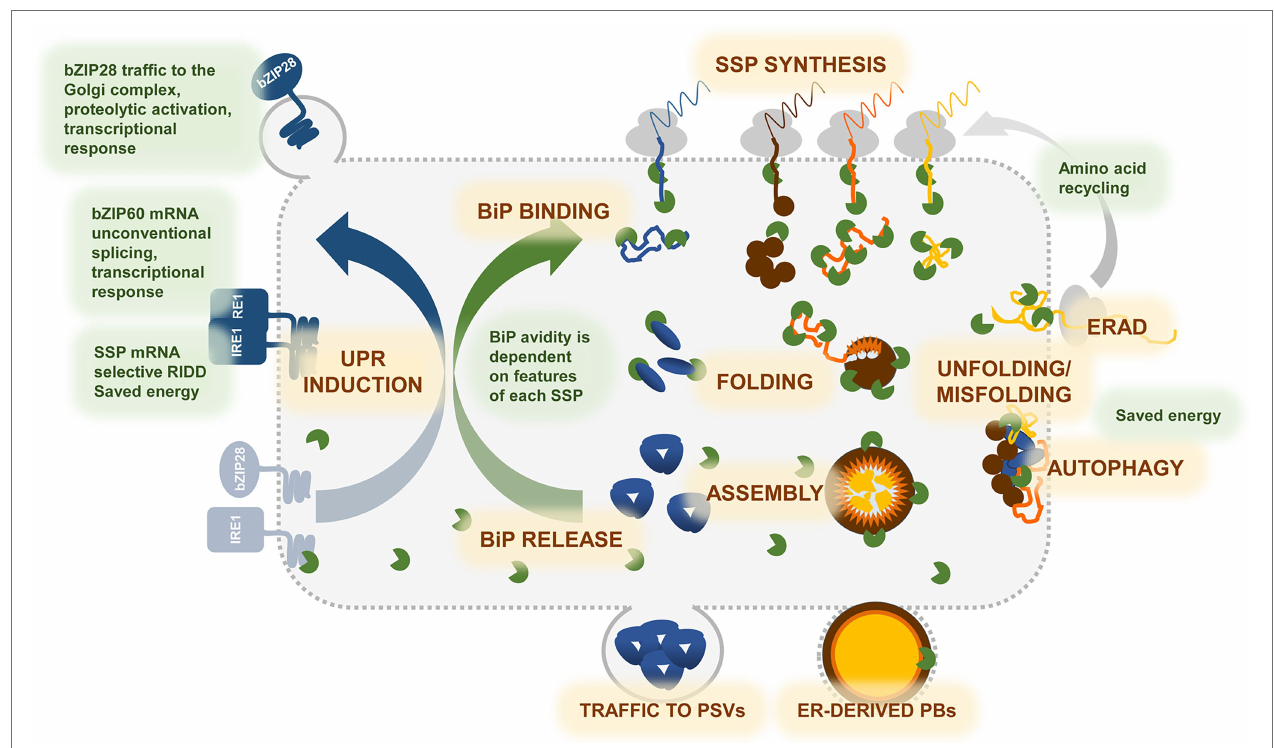
FIGURE 1 | Graphic representation of the events underlying synthesis and accumulation of storage proteins in developing seeds, and cross-talk with the UPR. During seed development, massive storage proteins synthesis drives significant developmental changes in cotyledonary or endorspermal cells, transforming them in professional secretory cells. Seed storage proteins (SSPs) are cotranslationally inserted into the ER—SSP SYNTHESIS, where they undergo oxidative folding assisted by ER chaperones and enzymes—FOLDING. BiP (green) plays a major role in the folding process, masking hydrophobic regions in the unfolded SSPs, avoiding their aggregation, and guiding folding toward the correct conformation—BiP BINDING. Structure and final localization of each SSP determine its affinity for BiP and binding extent in time. Other co-chaperones, such as ERdjs, PDIs, ER lectins (not shown in the cartoon), assist and support folding in a protein-specific manner. Correct folding frees SSP monomers from BiP. In multimeric SSPs, the assembly process—ASSEMBLY—is also needed to displace BiP—BiP RELEASE. Trimeric globulins (blue polypeptides), such as phaseolin, rapidly assemble and enter traffic to the protein storage vacuoles (PSV)—TRAFFIC TO PSVs. Zein prolamins (brown, orange, and yellow polypeptides) form very large heteropolymers—ER-DERIVED PBs—that may require long time to assembly correctly and do not enter traffic. Biogenesis of prolamin PBs is therefore a process that challenges the ER machinery to a greater extent. When folding fails—UNFOLDING/ MISFOLDING—SSPs which have not passed the ER quality control are degraded by ER-associated degradation—ERAD—or by AUTOPHAGY. Degradation of misfolded proteins provides amino acids to be immediately recycled into newly synthesized SSPs. Binding of BiP to the ER stress sensors IRE1 and bZIP28 links the folding process to the unfolded protein response—UPR INDUCTION. When the folding demand exceeds the ER capacity, the two sensors freed from BiP, activate the UPR pathway, that results in increasing the ER folding as well as ERAD and autophagic machineries. Selective regulated Ire1-dependent decay (RIDD) of SSP transcripts possibly also occurs to avoid ER overloading. Notice that anticipatory UPR (see main text) is not illustrated, since its signaling in seeds is not